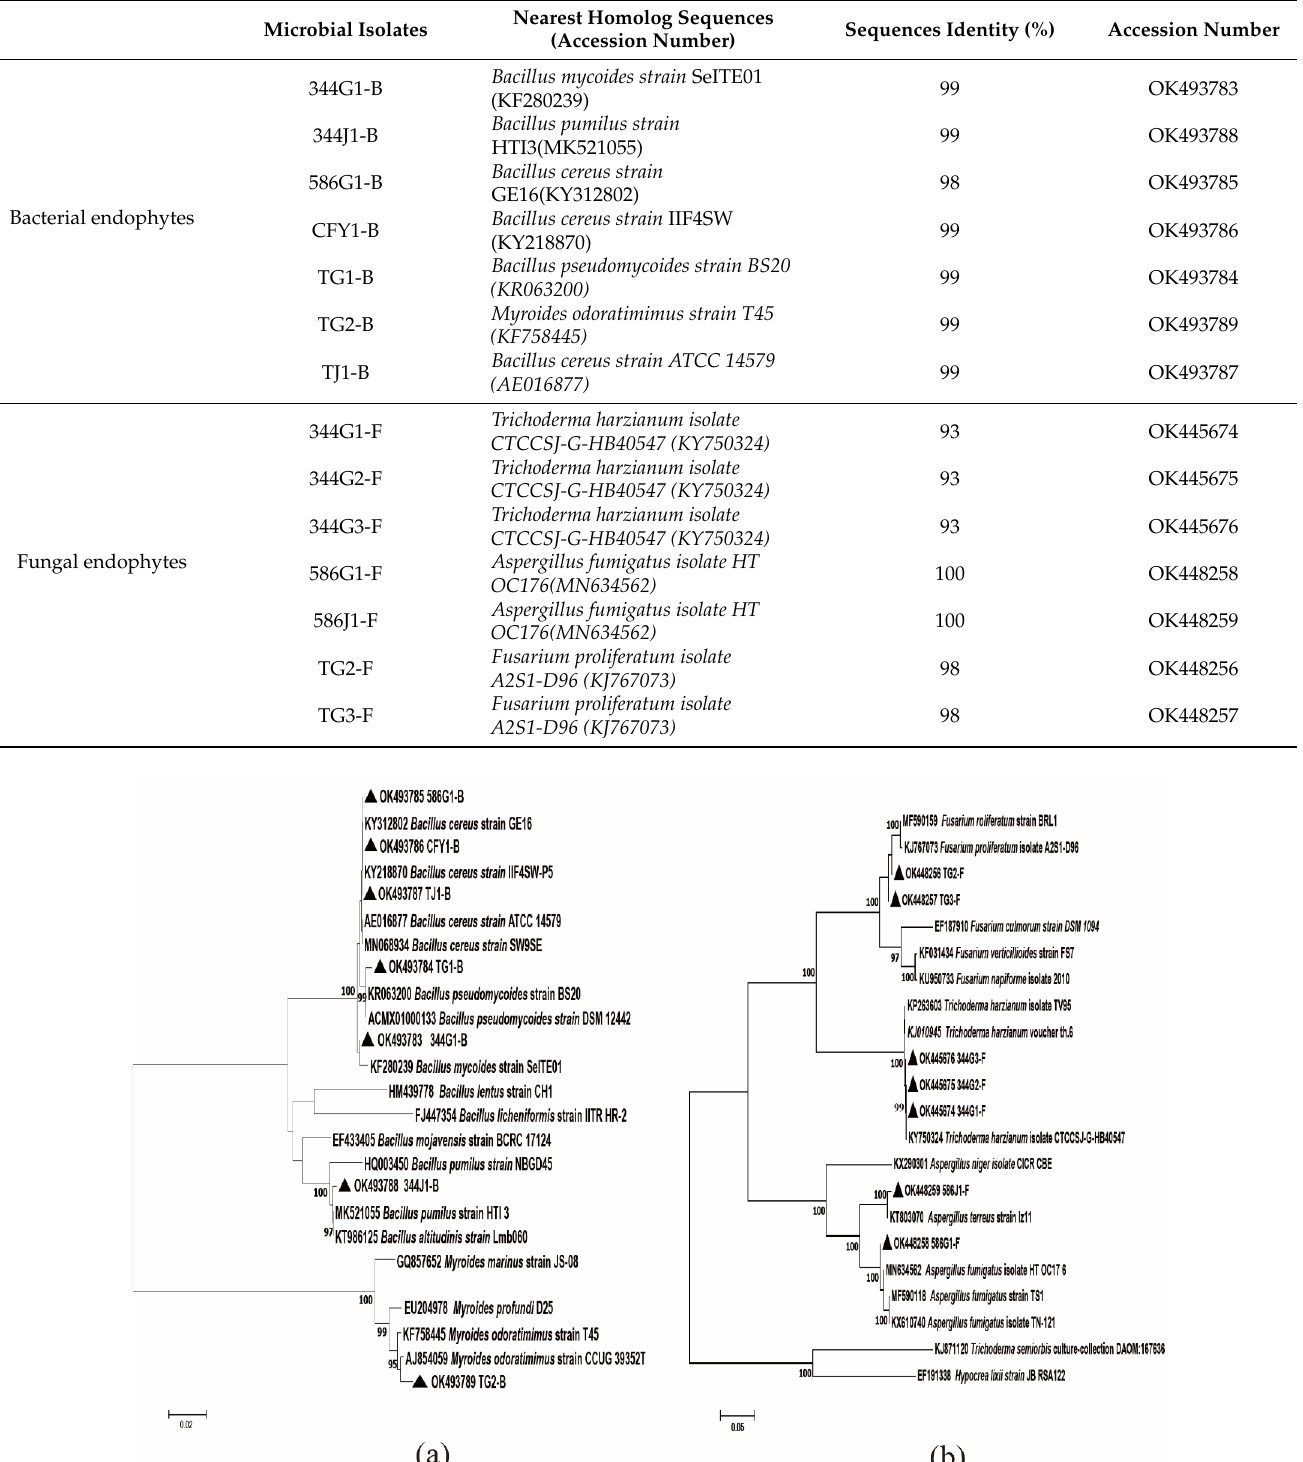
Table 2. The molecular identification of endophytic microbial isolates from D. glomerata . Nearest Homolog Sequences Microbial Isolates (Accession Number)